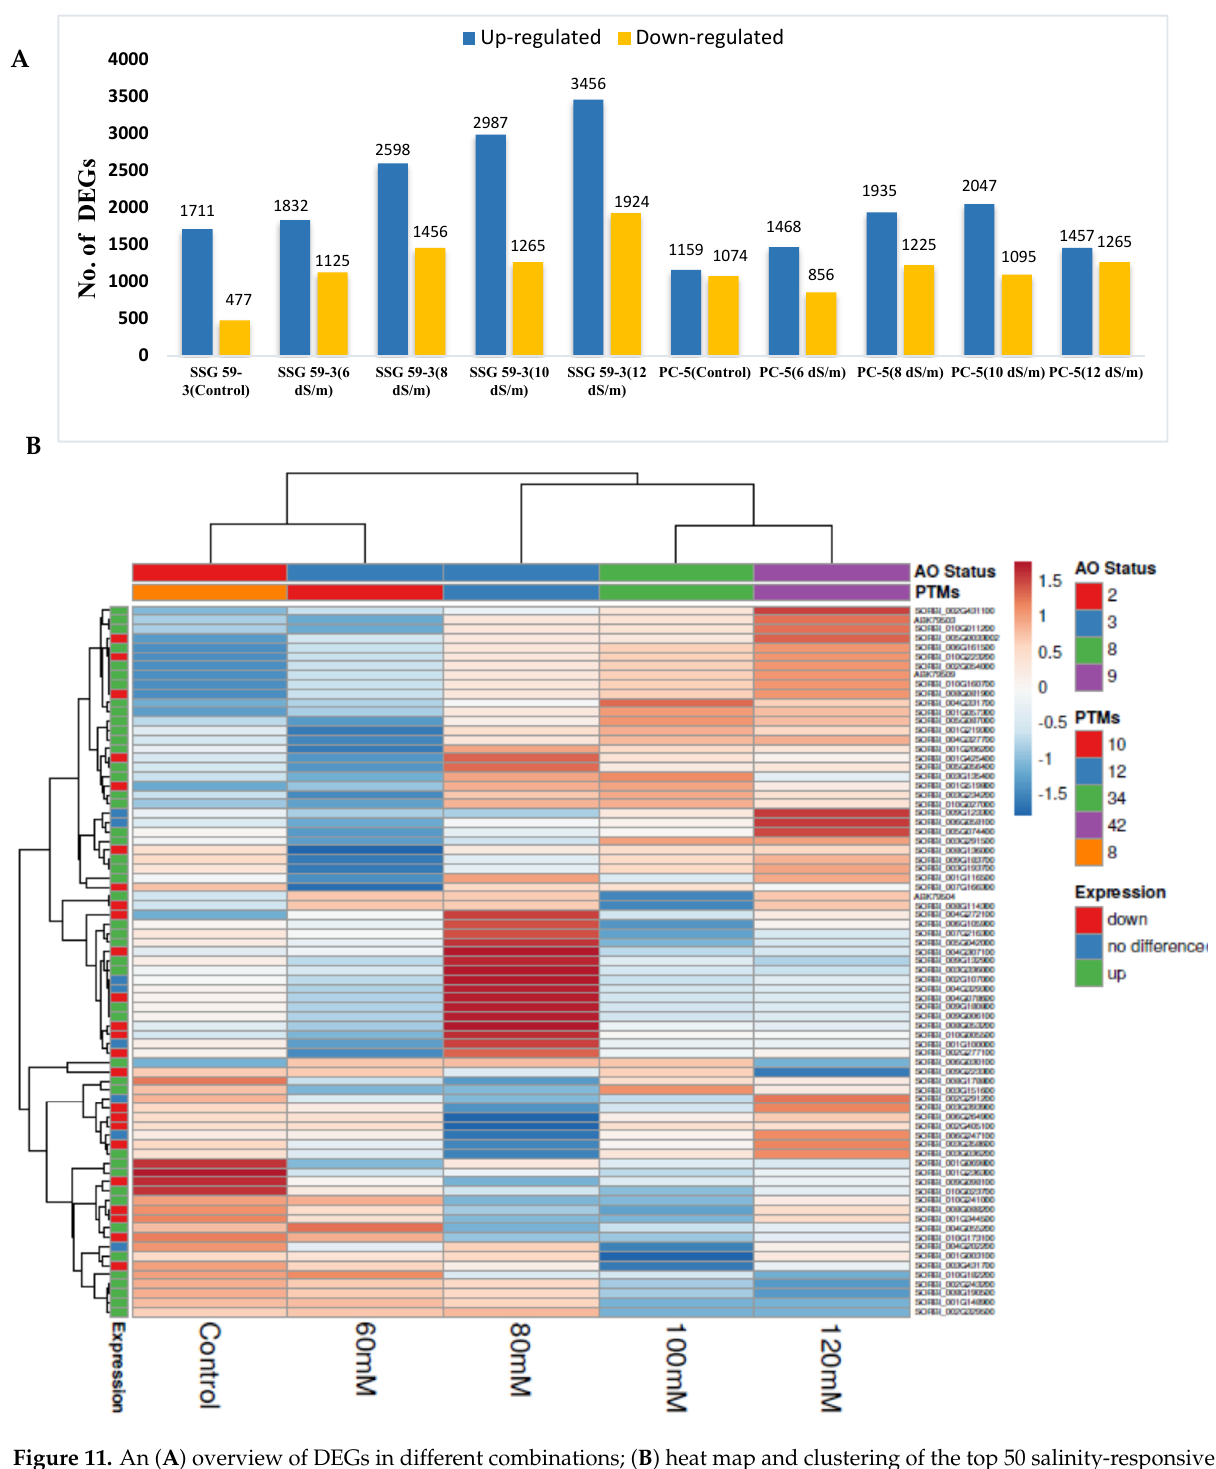
Figure 11. An ( A ) overview of DEGs in different combinations; ( B ) heat map and clustering of the top 50 salinity-responsive DEGs in control and stressed shoot tissues of SSG 59-3 (salt-tolerant) and PC-5 (salt-sensitive) sorghum genotypes using Clustvis (https://biit.cs.ut.ee/clustvis/, accessed on 19 June 2021).